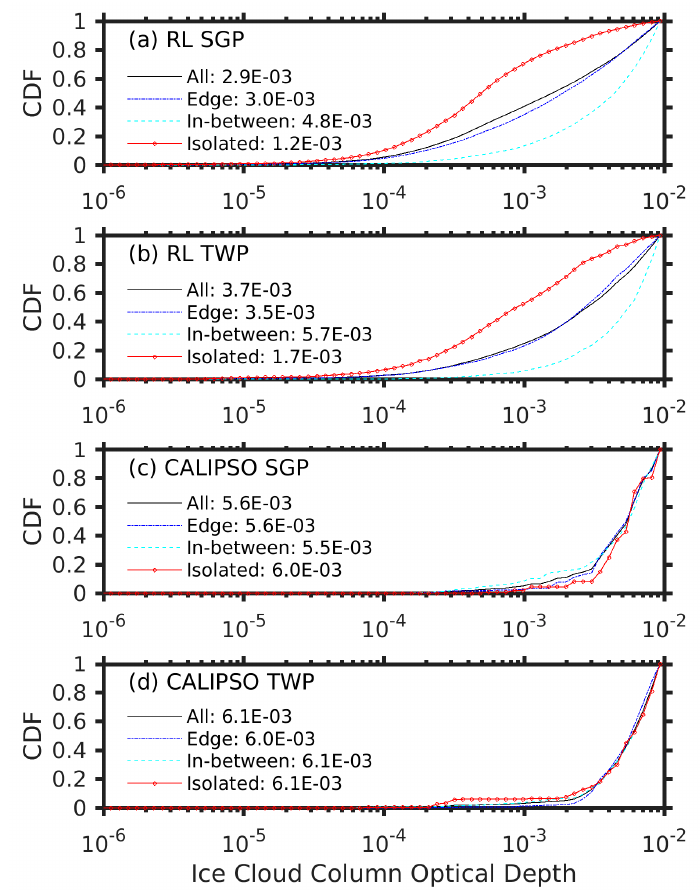
Figure 5. Cumulative distribution functions (CDFs) of ice cloud column optical depths below 0.01 (solid black) as well as those separated into 3 categories: cloud edges (dot dashed dark blue), in-between (dashed light blue) and isolated (circle red) for ( a ) RL SGP, ( b ) RL TWP, ( c ) CALIPSO SGP and ( d ) CALIPSO TWP. Mean values are given. Data for the RL at the SGP site are from August 2008 to August 2016 and at the TWP site from December 2010 to January 2015. Data for CALIPSO for both the SGP and TWP site are from June 2006 to August 2016.